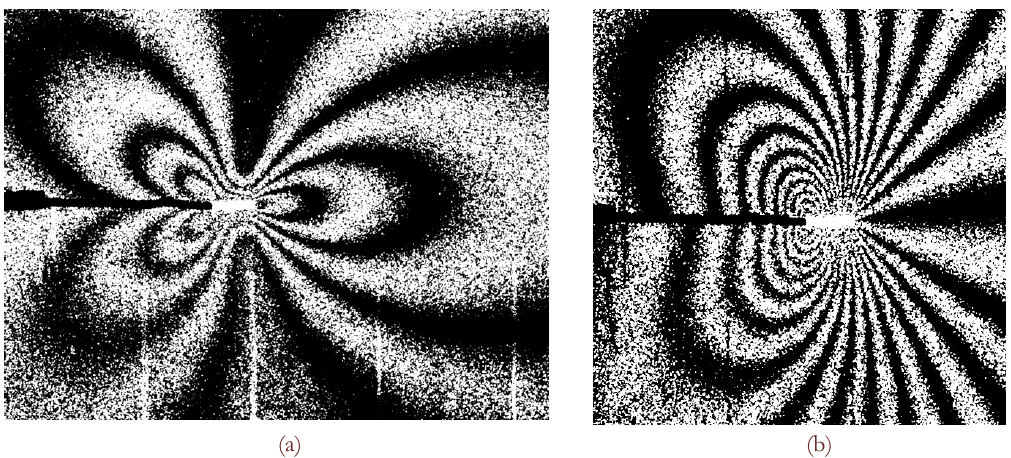
Figure 2: Specimen #3V. Interference fringe pattern obtained in terms of in-plane displacement component u (a) and v (b). Initial crack length a = 7.18 mm with increment Δ a = 1.81 4 5